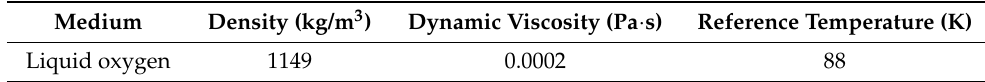
Table 4. Properties of the fluid medium.